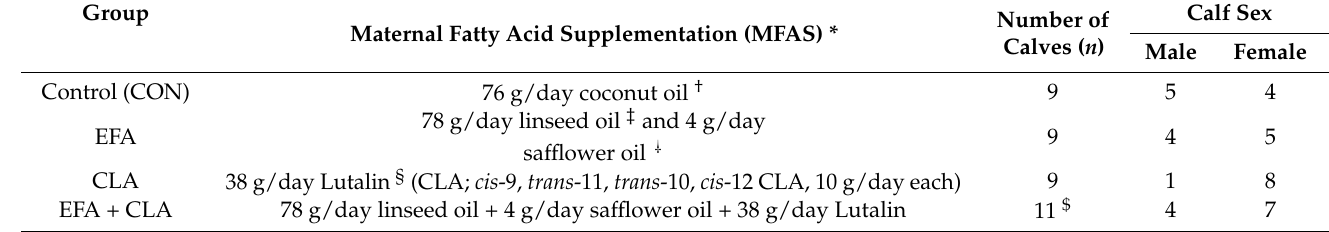
Table 1. Experimental design and animals.